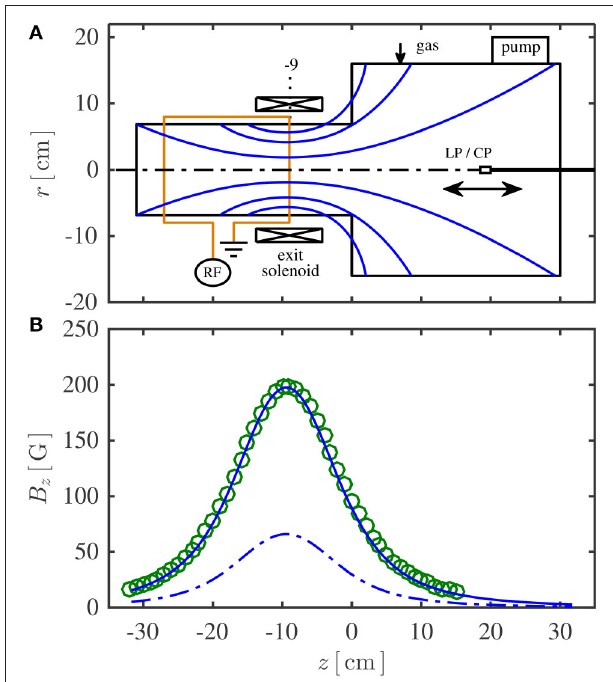
FIGURE 1 | (A) Chi-Kung reactor implemented with a convergent-divergent magnetic field, showing major components and diagnostic probes. The calculated magnetic field lines are plotted as solid curves within the reactor geometry. (B) On-axis magnetic flux density B z generated with the 9-A high solenoid current, measured using a gaussmeter (open circles) and calculated from the Biot-Savart law (solid line), and calculated results for the 3-A low solenoid current (dash-dotted